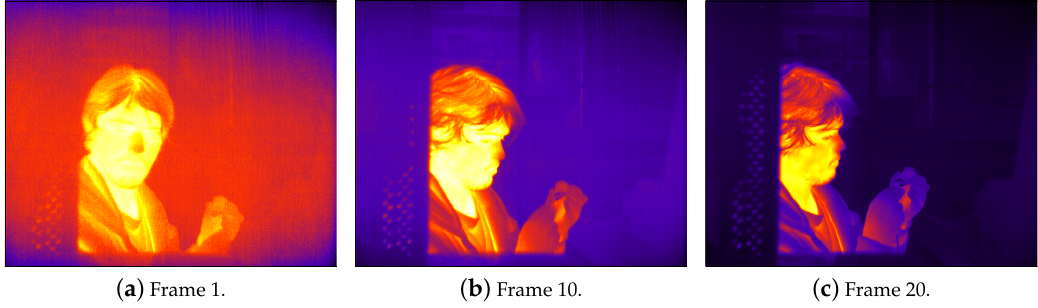
Figure 4. Model output on FLIR core at startup, T FPA = 22 ◦ C.